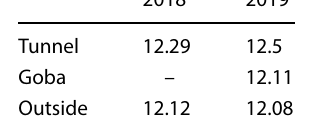
Table 4 Mean annual air temperature in the Škocjanske Jame and outside in